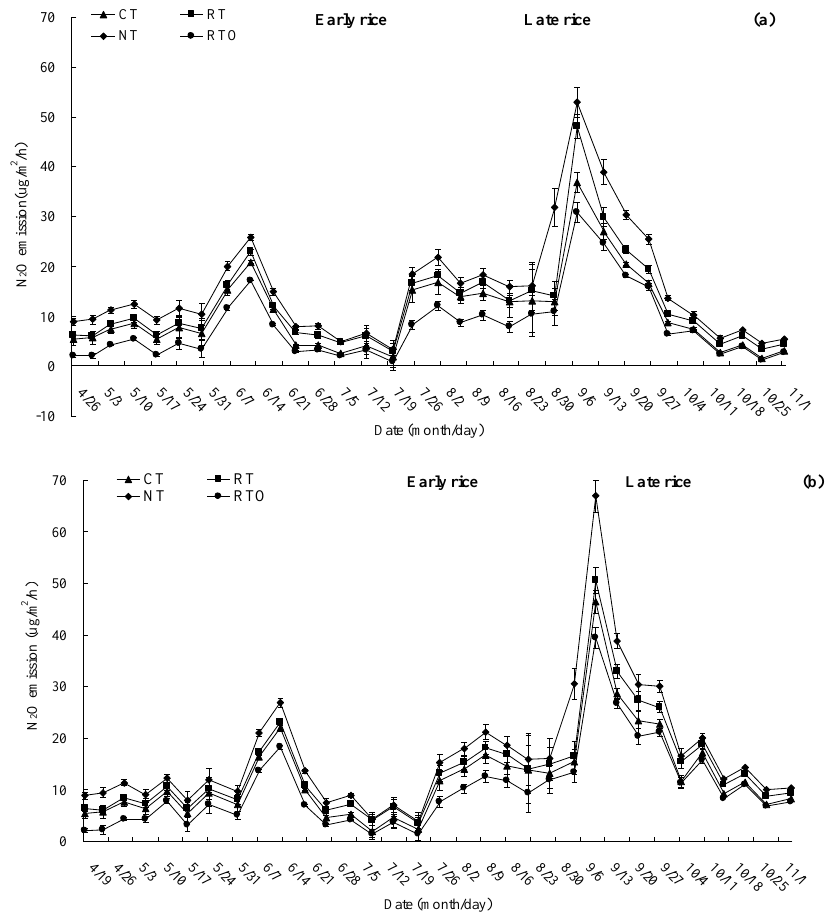
Figure 4. Impacts of different short-term tillage managements on N 2 O emission flux from double-cropping rice field in 2019 ( a ) and 2020 ( b ).